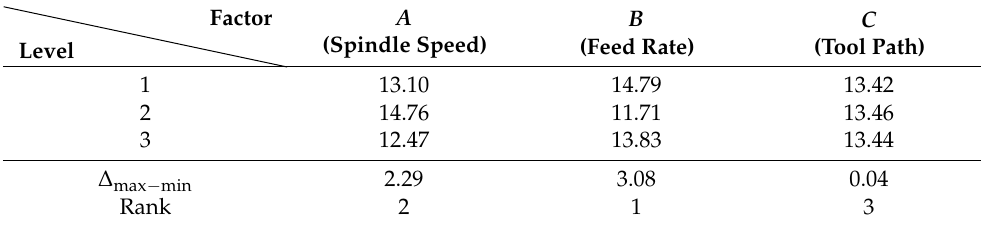
Table 15. Response table for S/N ratios for surface